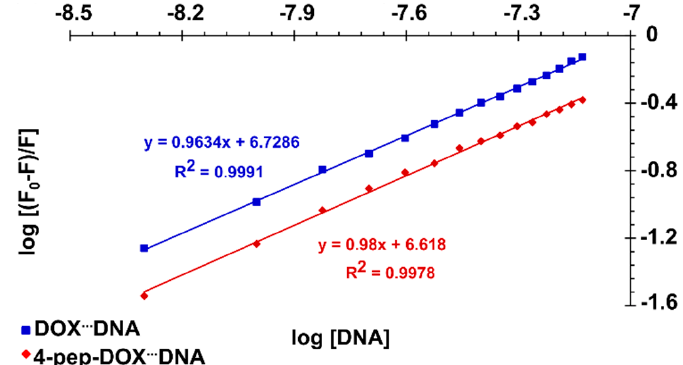
(cid:104) (cid:105) (cid:3007) (cid:3116) (cid:2879)(cid:3007) (cid:4671) vs. log (cid:4670)DNA(cid:4671) for the DOX … dsDNA and 4-pep–DOX … dsDNA systems in F 0 − F Figure 8. Plots of log(cid:4670) Figure 8. Plots of log vs. log [ DNA ] for the DOX ... dsDNA and 4-pep–DOX ... dsDNA systems (cid:3007) F in 10 mM Tris-HCl bu ff er (pH 7.2) at 25 ◦ 10 mM Tris-HCl buffer (pH 7.2) at 25 °C.